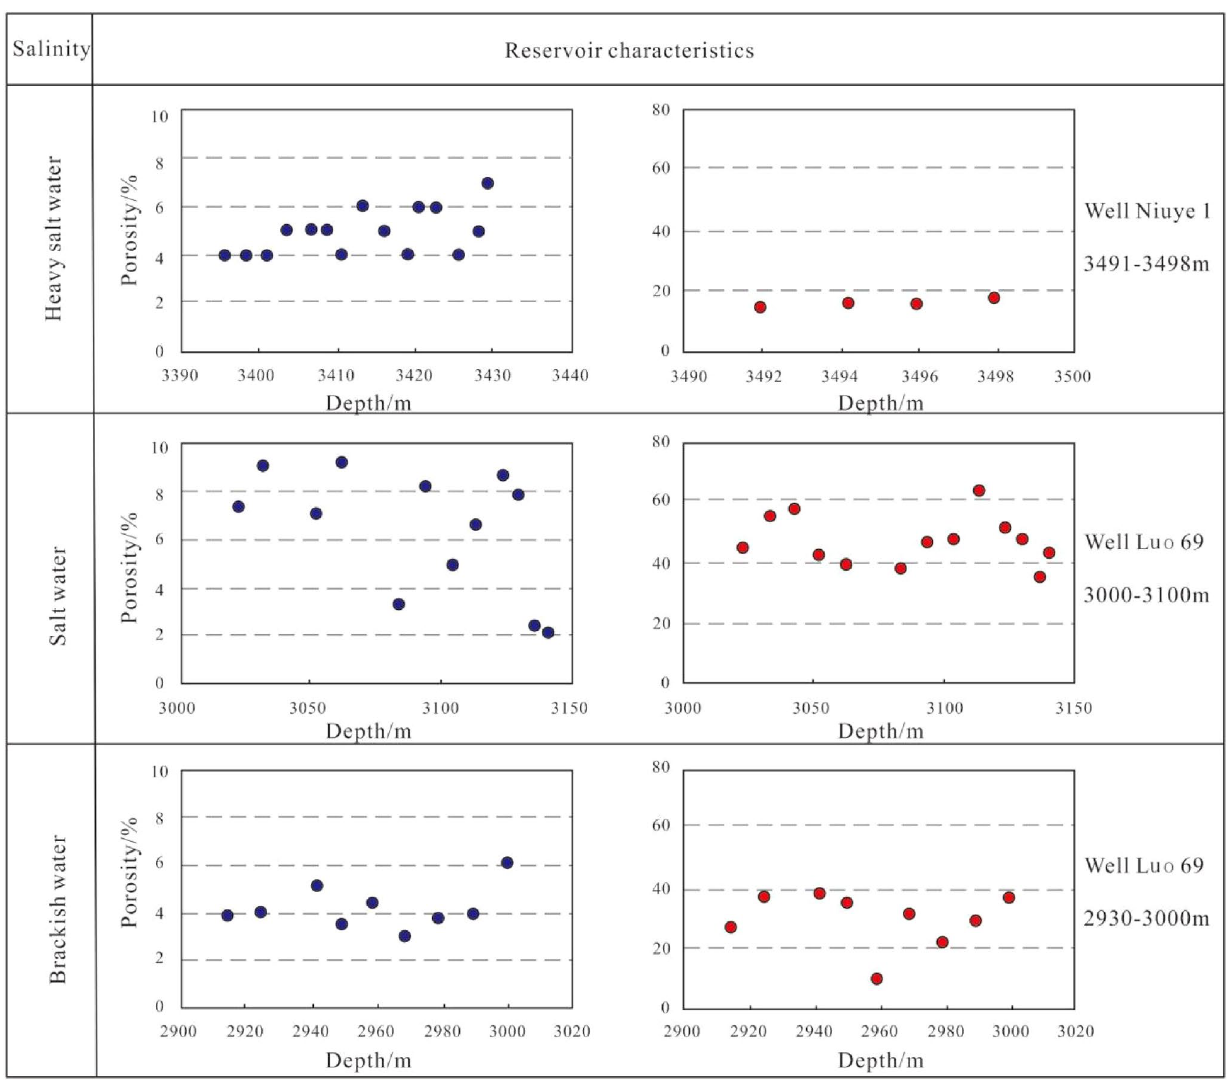
Fig. 9 reservoir characteristics at different saline